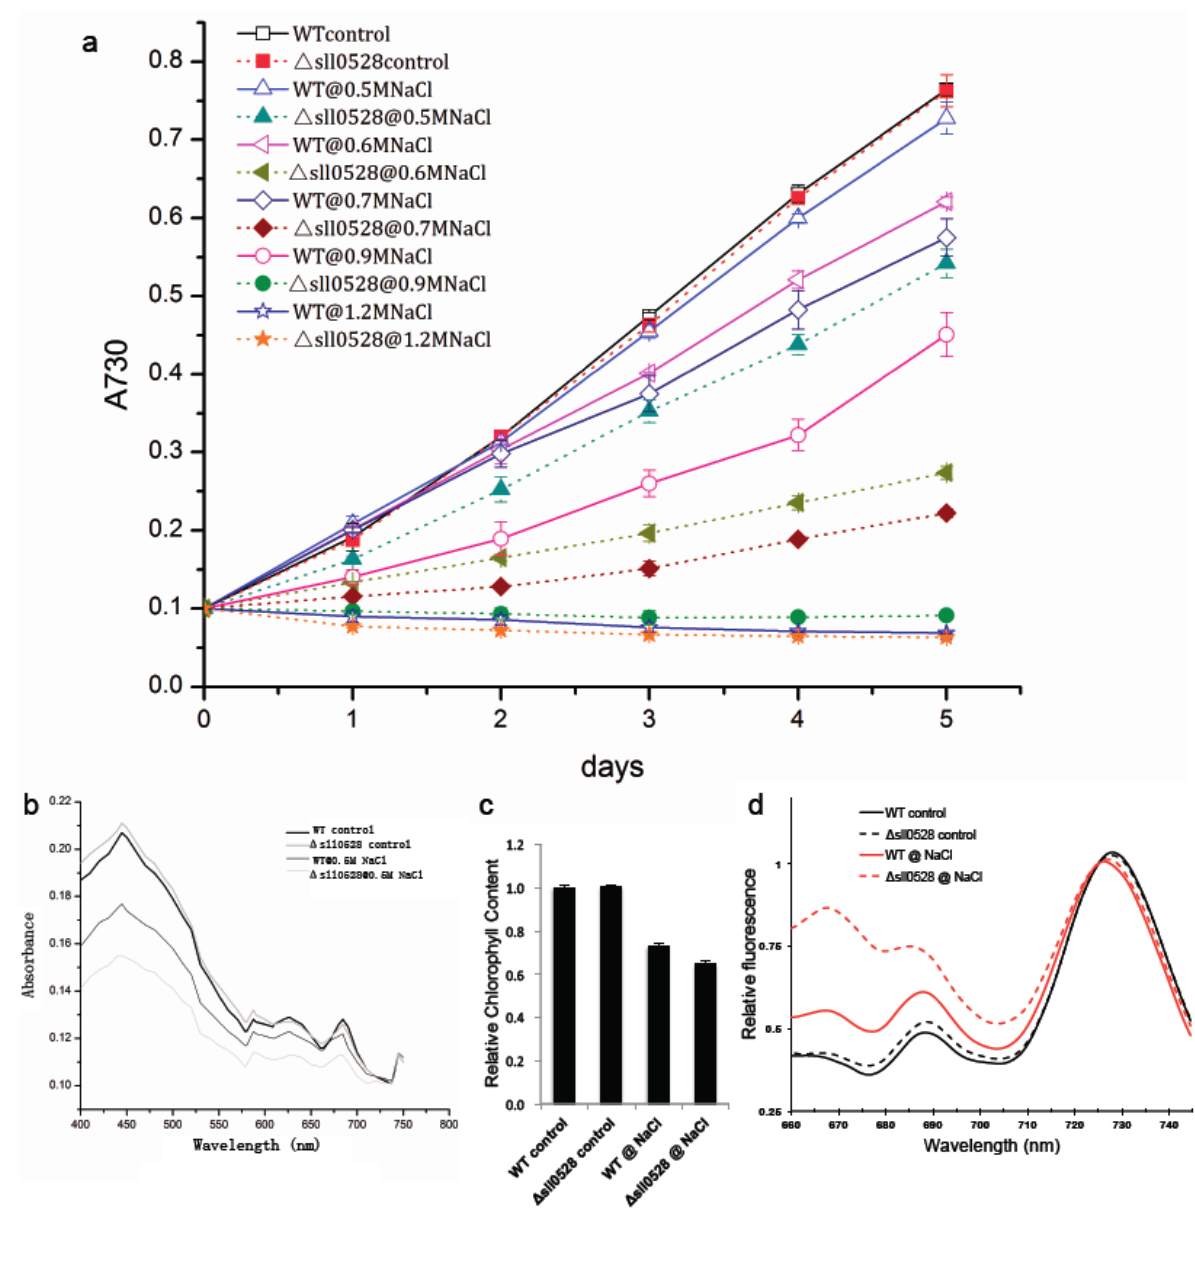
Figure 3. Increased sensitivity of sll0528 mutant to salt stress. ( a ) Growth curve of wild type (WT) and sll0528 mutant ( Δ sll0528 ) at different concentration of NaCl (0.5, 0.6, 0.7, 0.9, and 1.2 M respectively). Significant differences were observed between mutant and wild type from the 2nd day to 5th day at NaCl of 0.5, 0.6, 0.7 and 0.9 M ( p < 0.05). Initial OD 730 was 0.1. Each data point represents the mean of at least three independent biological replicates, and the error bars denote SD; ( b ) Absorption spectra of wild type and sll0528 mutant 24 h after transfer to 0.5 M NaCl, normalized to OD 730 ; ( c ) Relative chlorophyll content of wild type and mutant; ( d ) The 77 K fluorescence emission spectra of wild type and mutant with excitation at 435 nm. Spectra were normalized to emission at 725